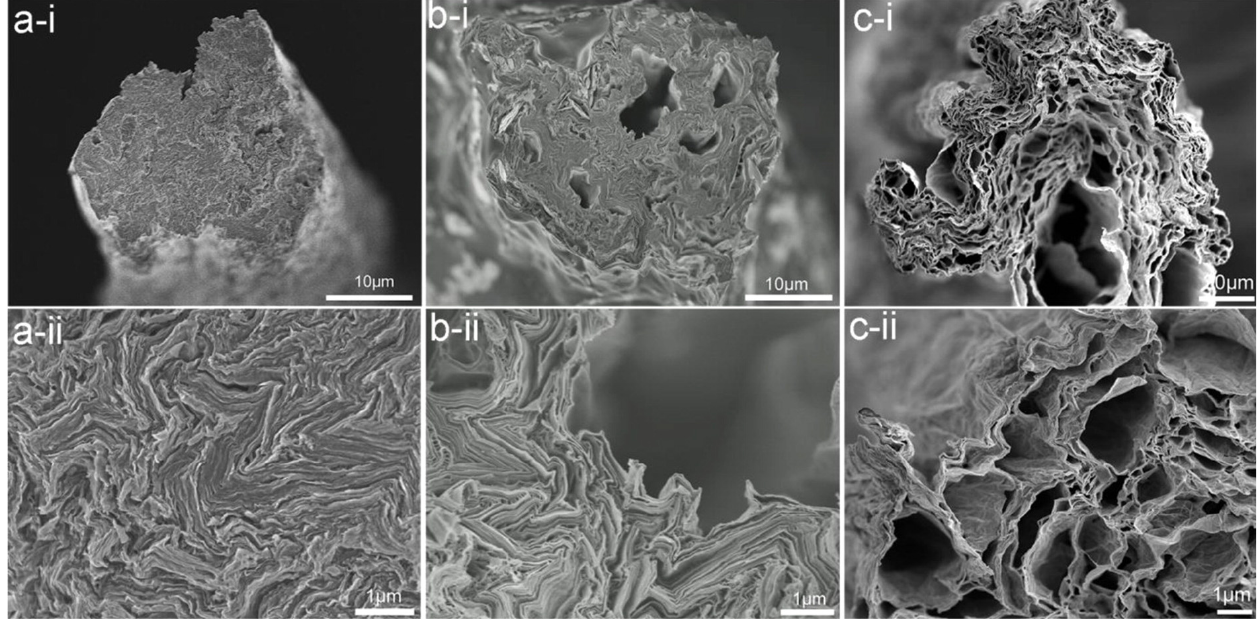
Figure 4. The morphological structure of the graphene fibres at different magnifications, produced from various coagulation bath: ( a - i ) and ( a - ii ) water, ( b - i ) and ( b - ii ) acetone, and ( c - i ) and ( c - ii ) acidic medium (pH-3); Reprinted with permission from [78].